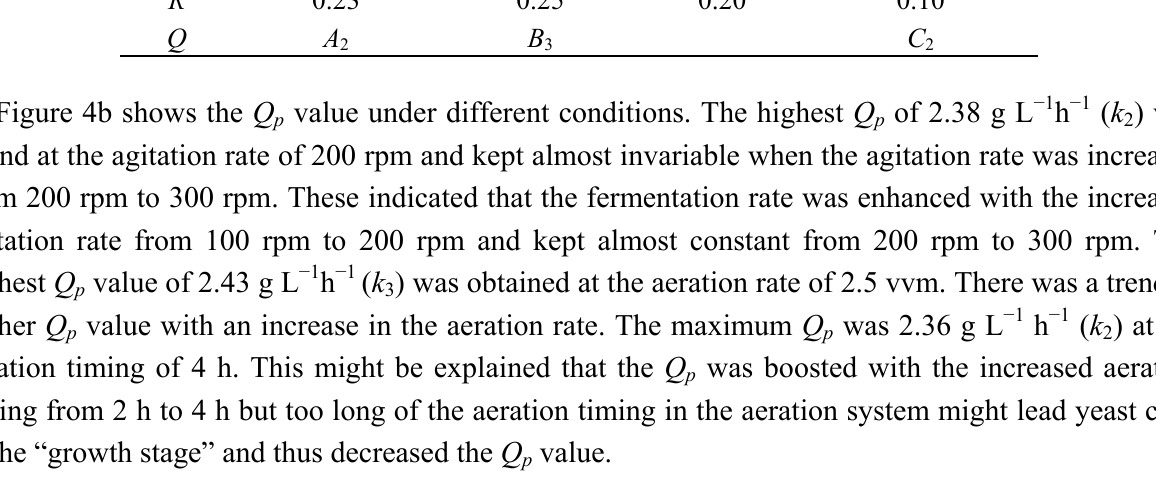
(3 4 ) orthogonal experiments for ethanol productivity. 9